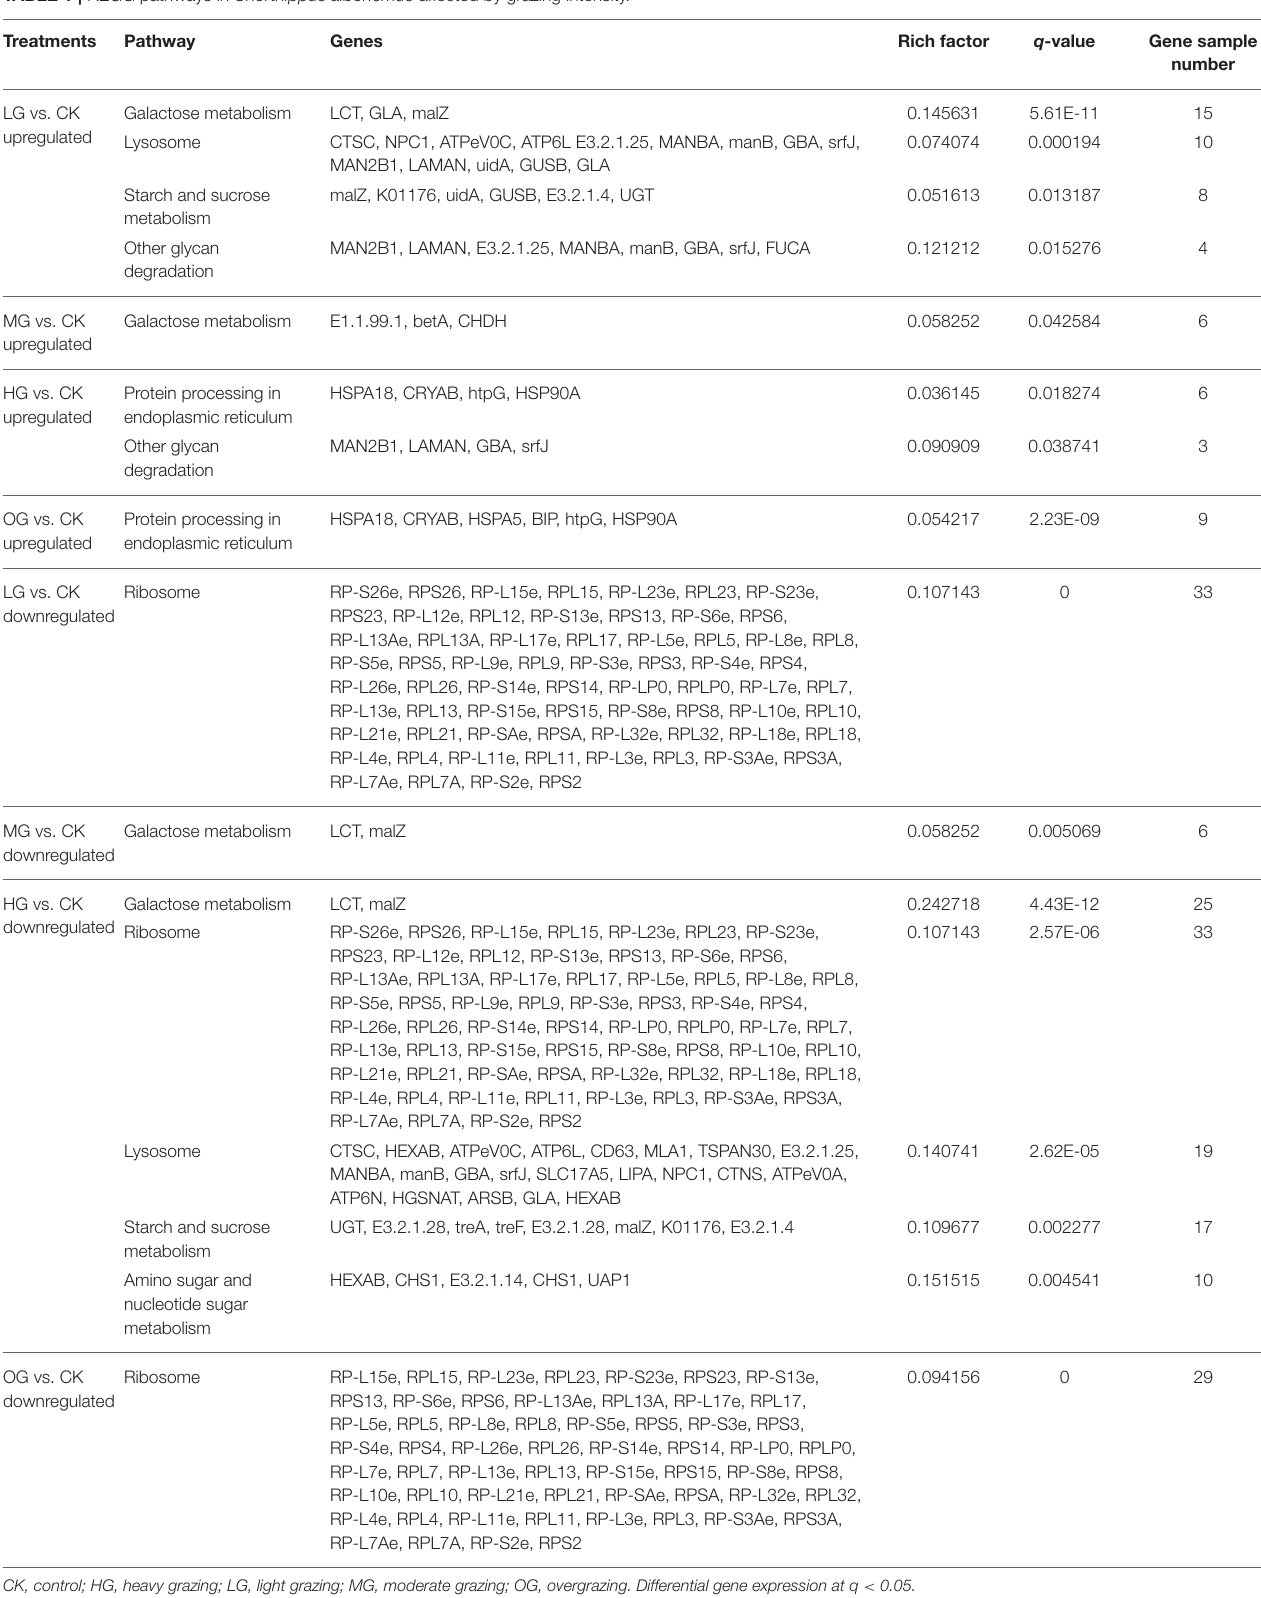
TABLE 1 | KEGG pathways in Chorthippus albonemus affected by grazing intensity. Treatments Pathway Genes Rich factor q -value Gene sample